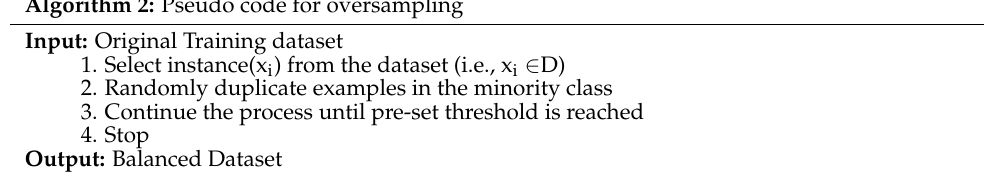
Figure 2. Oversampling and undersampling process. Algorithm 2: Pseudo code for